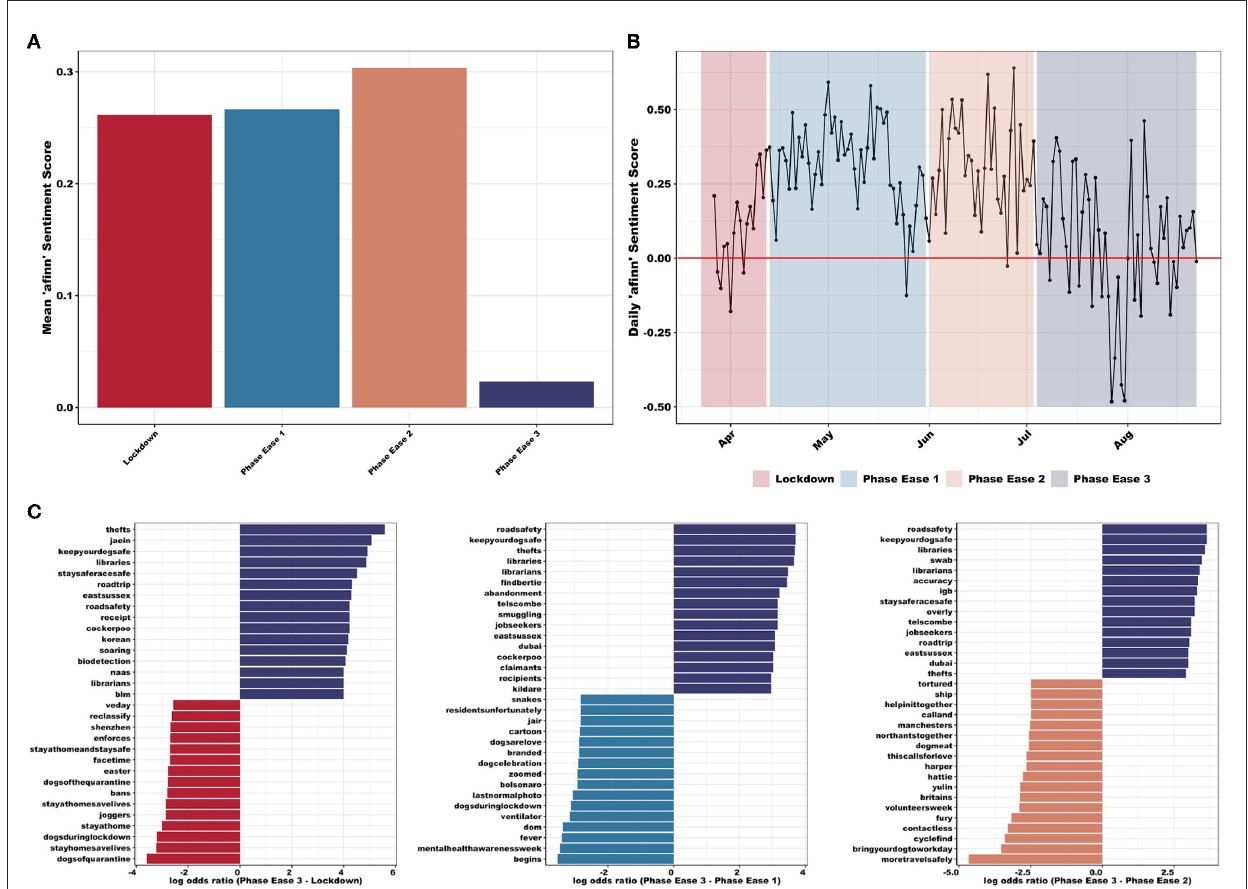
FIGURE3 (A) Mean afinn sentiment scores differed significantly between the four phases ( F 3,78,508 = 44.4, p < 0.001) with PE3 exhibiting lower mean sentiment. (B) Daily afinn sentiment score (red line highlights zero, i.e., neutral and sentiment), presenting a decrease in sentiment during PE3 (i.e., increase in negative language use — regarding both intensity and frequency). Most negative days (and suggested potential reasons for these) include: 27th July (COVID-19 case was confirmed in cat in UK); 28th July (unknown reason); 30th July (increased local restrictions introduced in north-west England, no easing of further restrictions as planned elsewhere); 31st July (tighter lockdown restrictions introduced in north England and postponed easing); 5th August (tighter lockdown restrictions introduced to Aberdeen); and 14th August (UK experiencing heatwave and various news outlets reporting dogs left in hot cars). Most positive days (and suggested potential reasons for these) include: 1st May (news regarding COVID-19 testing and vaccines and Captain Tom Moore ’s 100th birthday flypast); 14th May (news of dogs trained to protect wildlife in Africa); 8th June (announcements of lockdown restrictions easing including opening of hospitality and travel); 11th June (introduction of “support bubbles”); 19th June (large easing of Welsh lockdown rules); and 27th June (good weather). (C) Log odds ratios comparing word usage between PE3 (purple) and all other phases